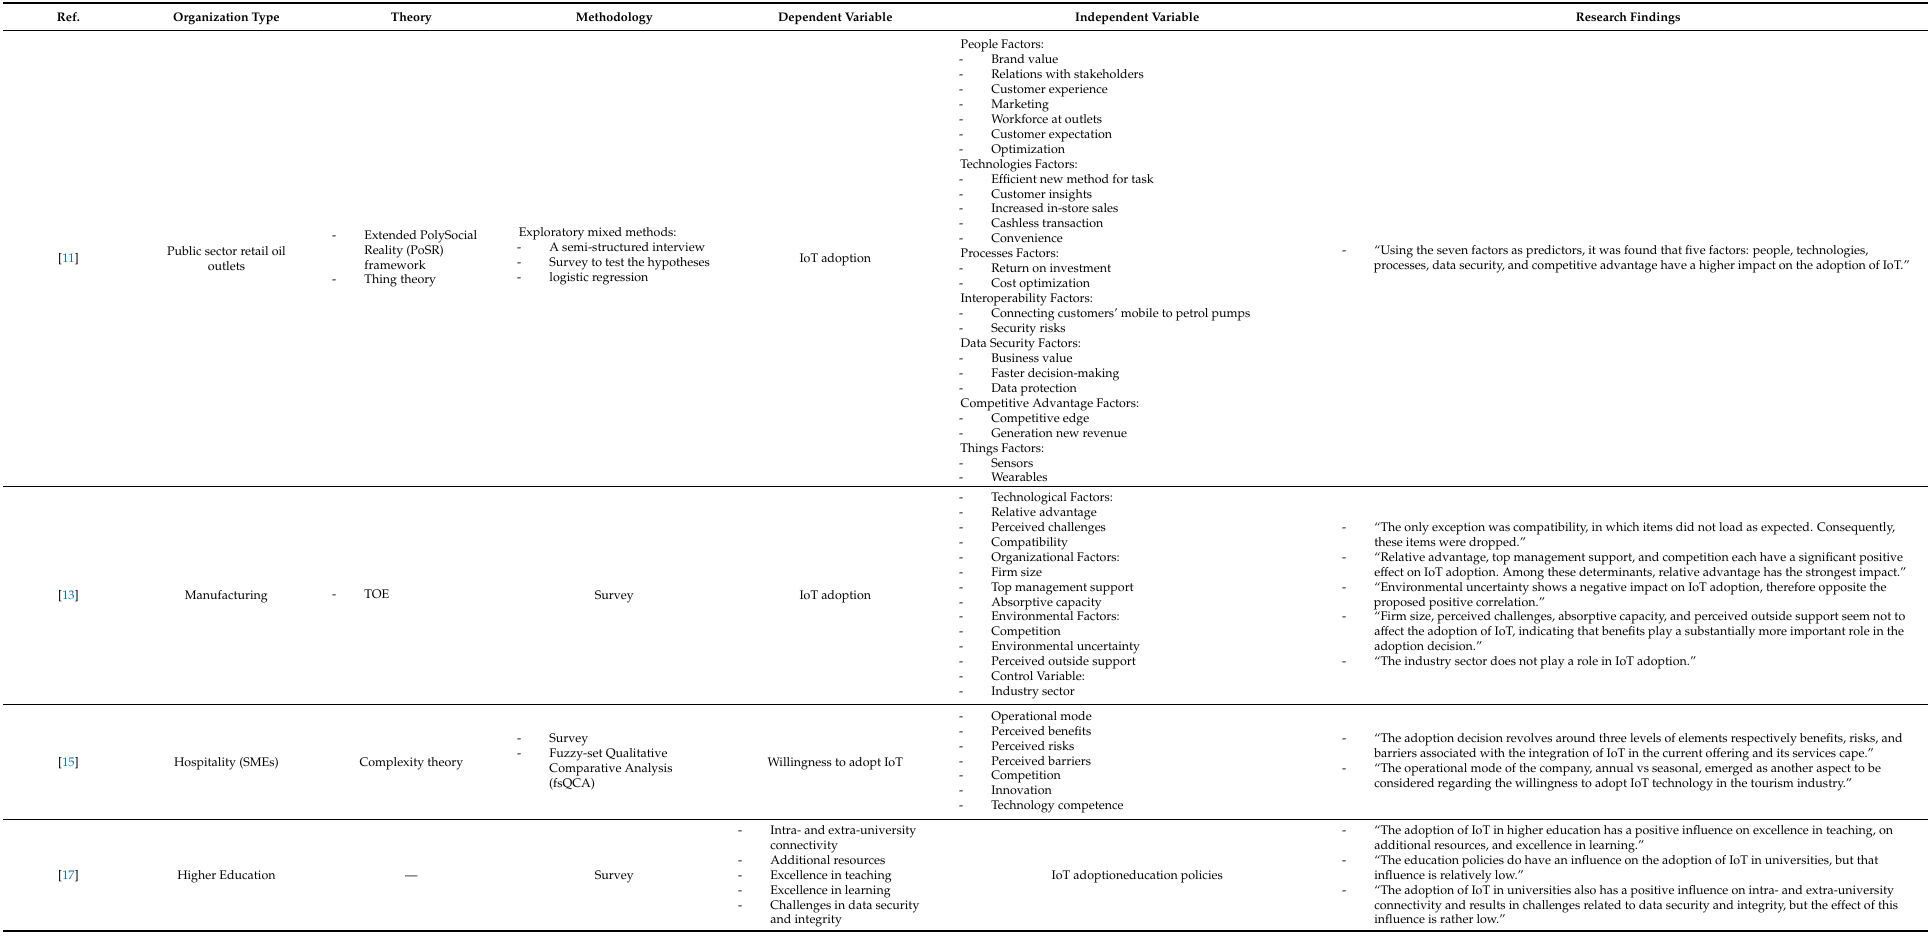
Table 5. The empirical studies examining the IoT adoption factors in the organizations.